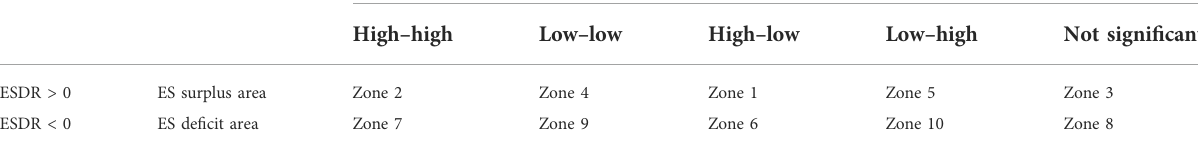
TABLE 4 Classi fi cation method of ES surplus